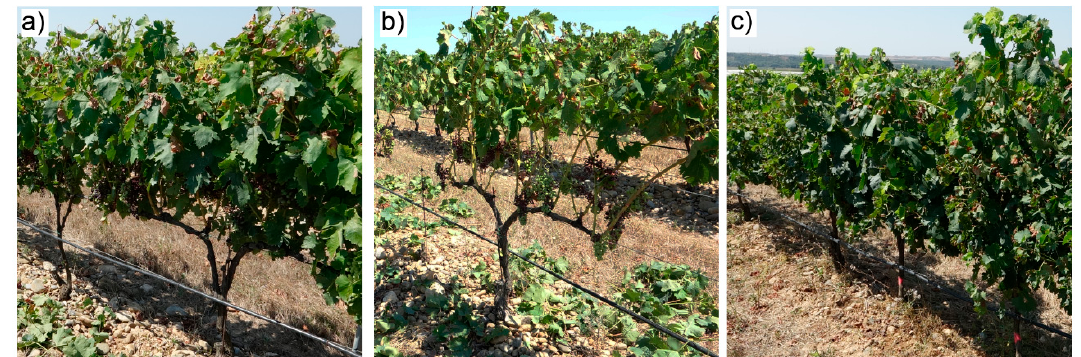
Figure 2. Pictures after leaf removal mode experiment in Traibuenas: ( a ) leaves removed from one side (LR-1s), ( b ) two sides (LR-2s), ( c ) control vines.